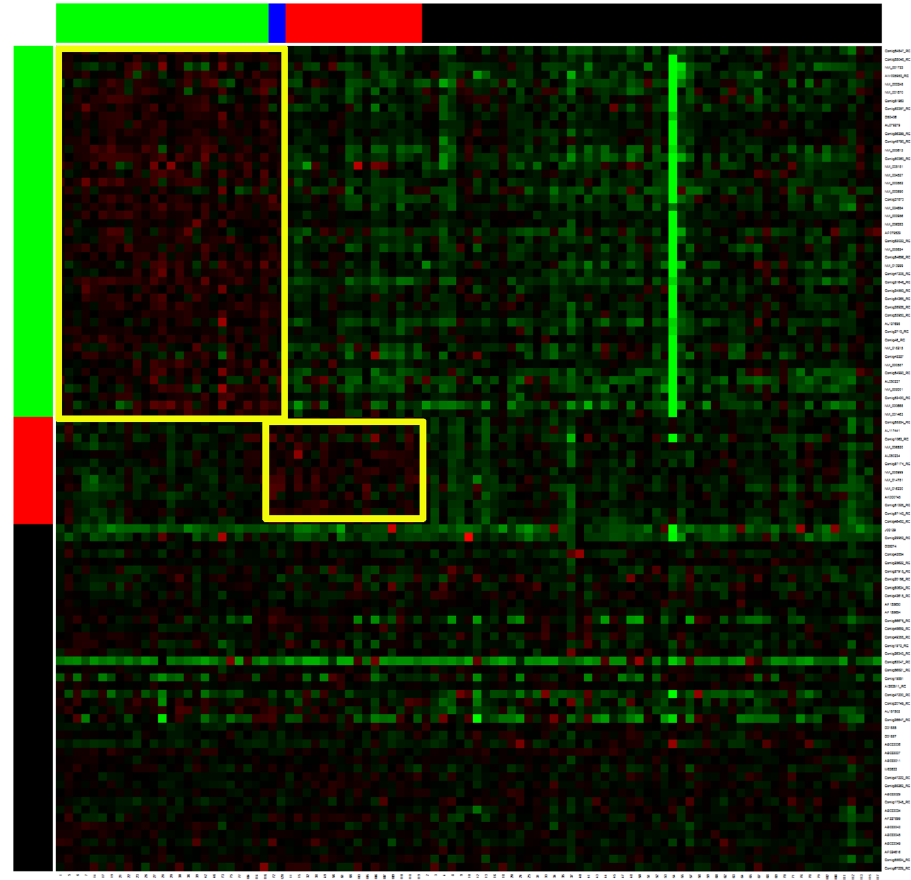
Figure 4. Breast Cancer data: two biclusters are identified, 45 6 27 and 13 6 18, using 6391 genes 100 of which are demonstrated.